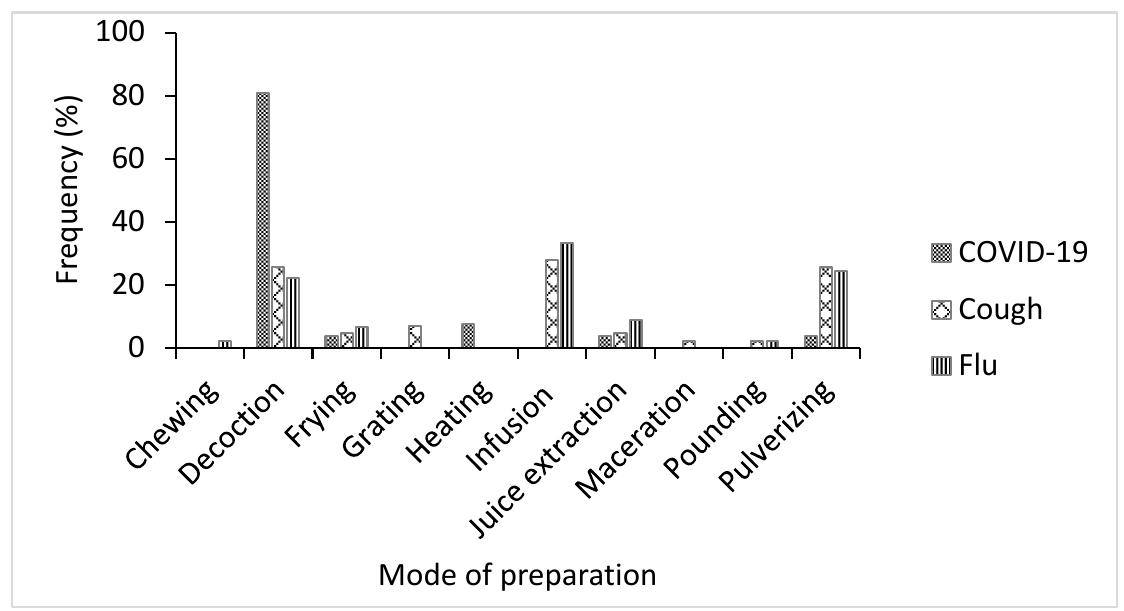
Figure 5. Methods of preparing medicinal plant species used for the treatment of COVID-19, cough, and flu in Ogbomosho North and South Local Government Areas, Oyo State, Nigeria.